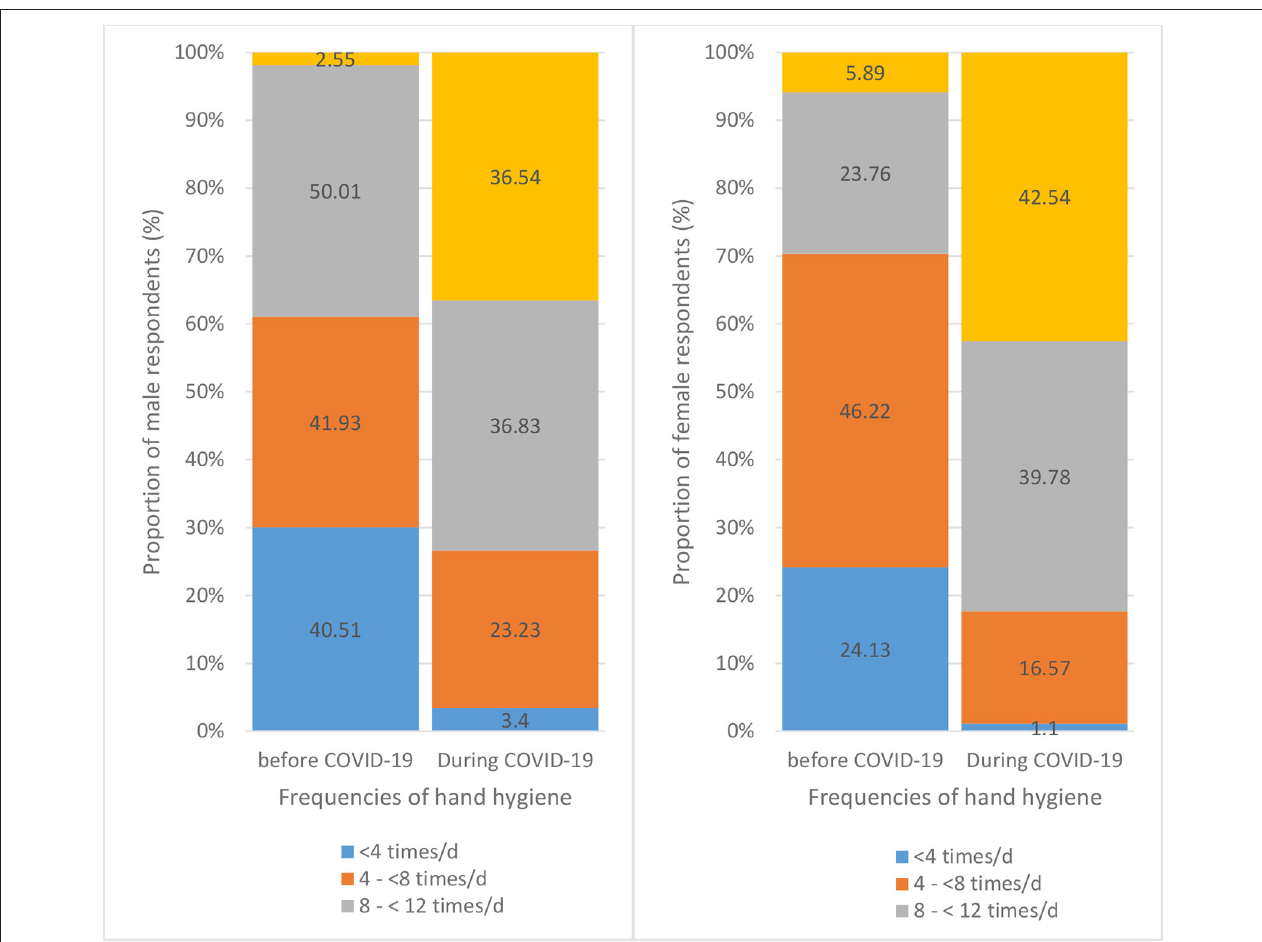
FIGURE 4 | Change in hygiene frequencies from before to during COVID-19 pandemic for male group (left) and female group